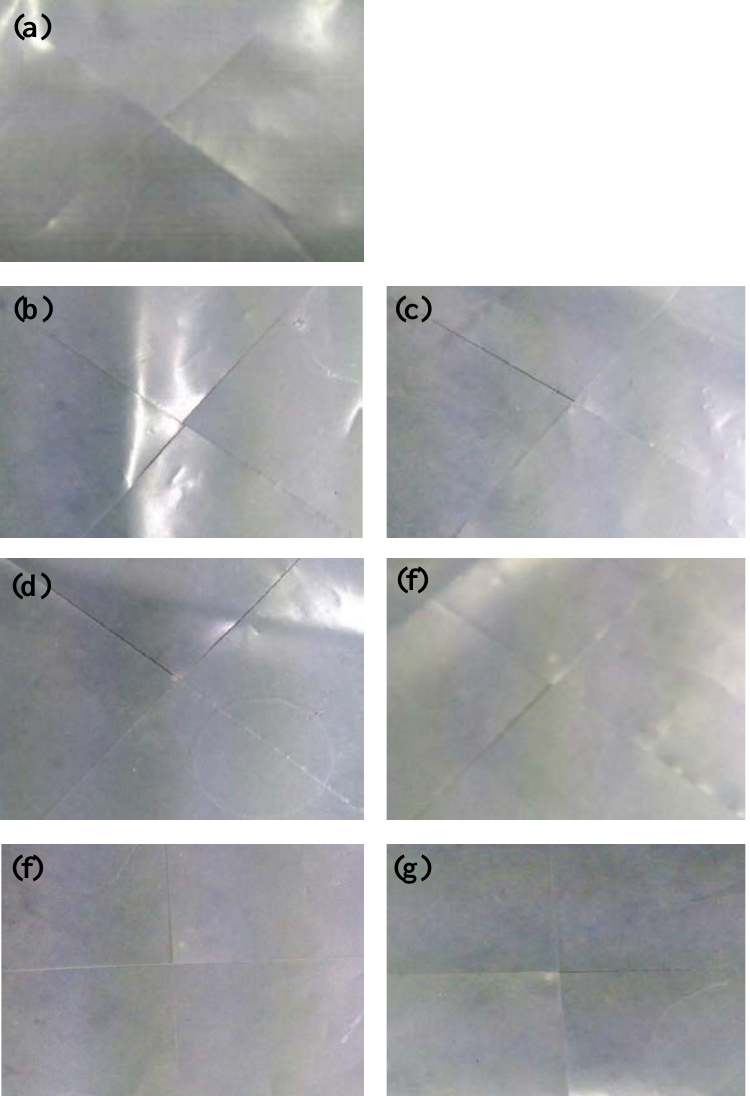
Figure 6. Polyester thermoplastic films with various contents of thermally expandable microcapsules after curl test.